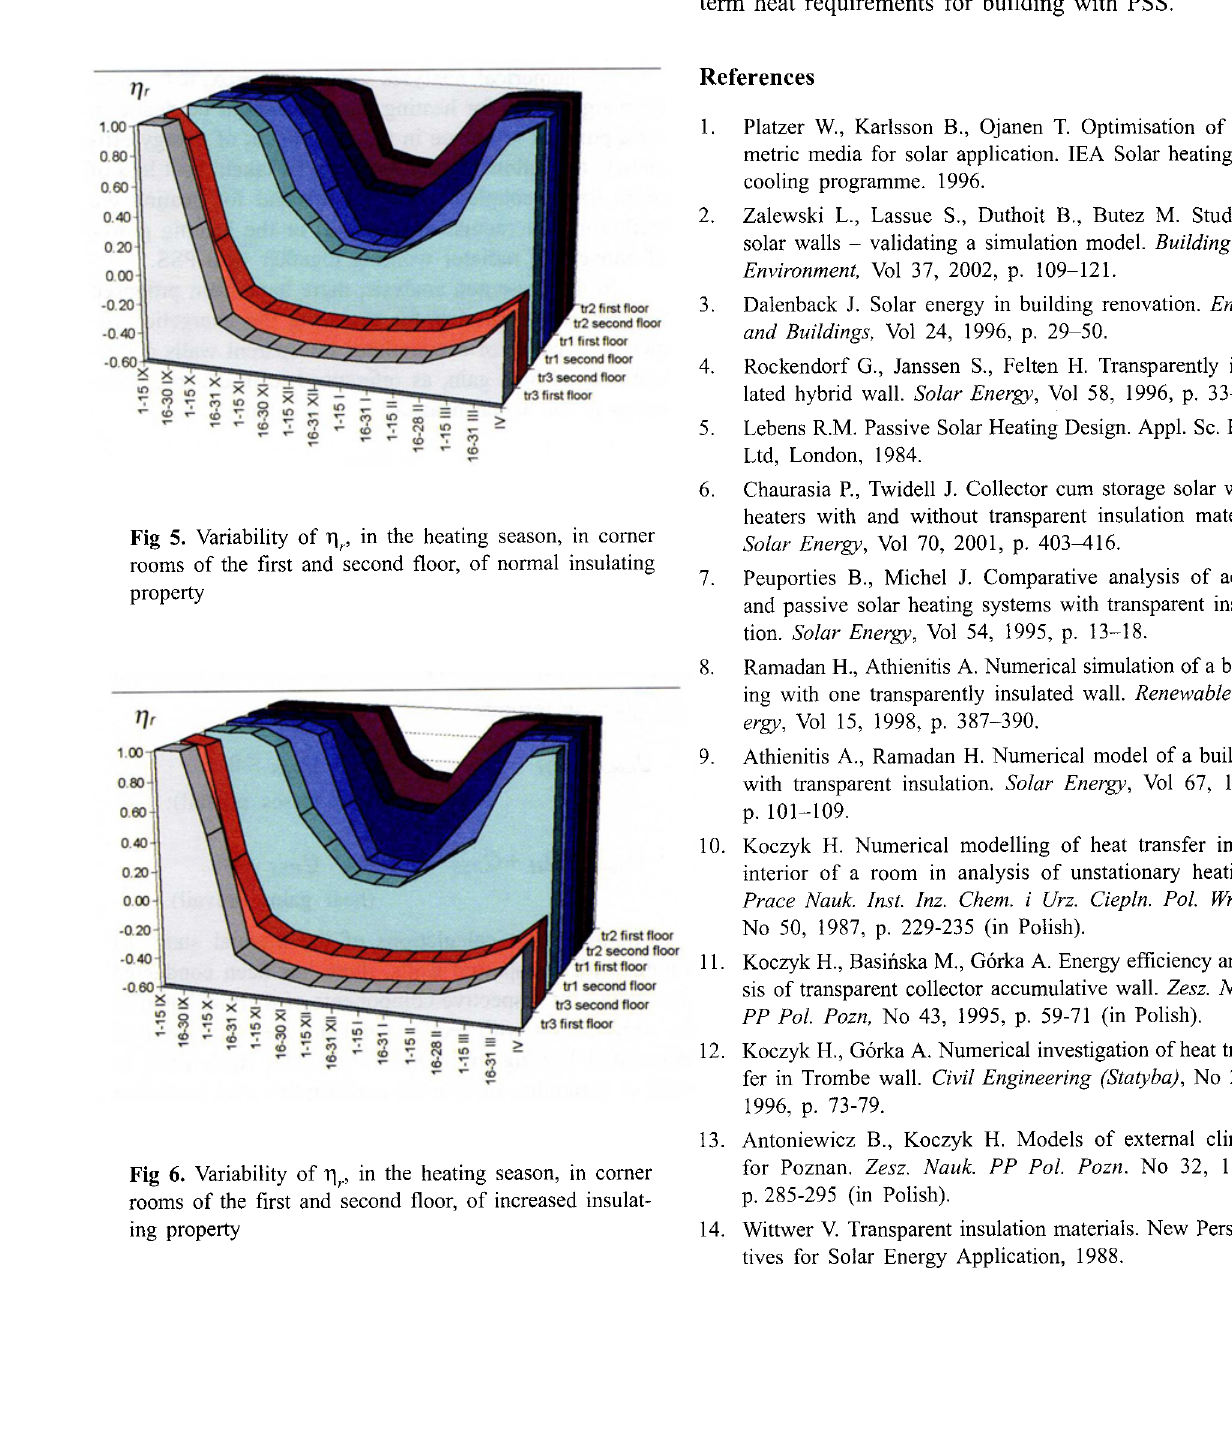
Fig 5. Variability of Tlr' in the heating season, in comer rooms of the first and second floor, of normal insulating property